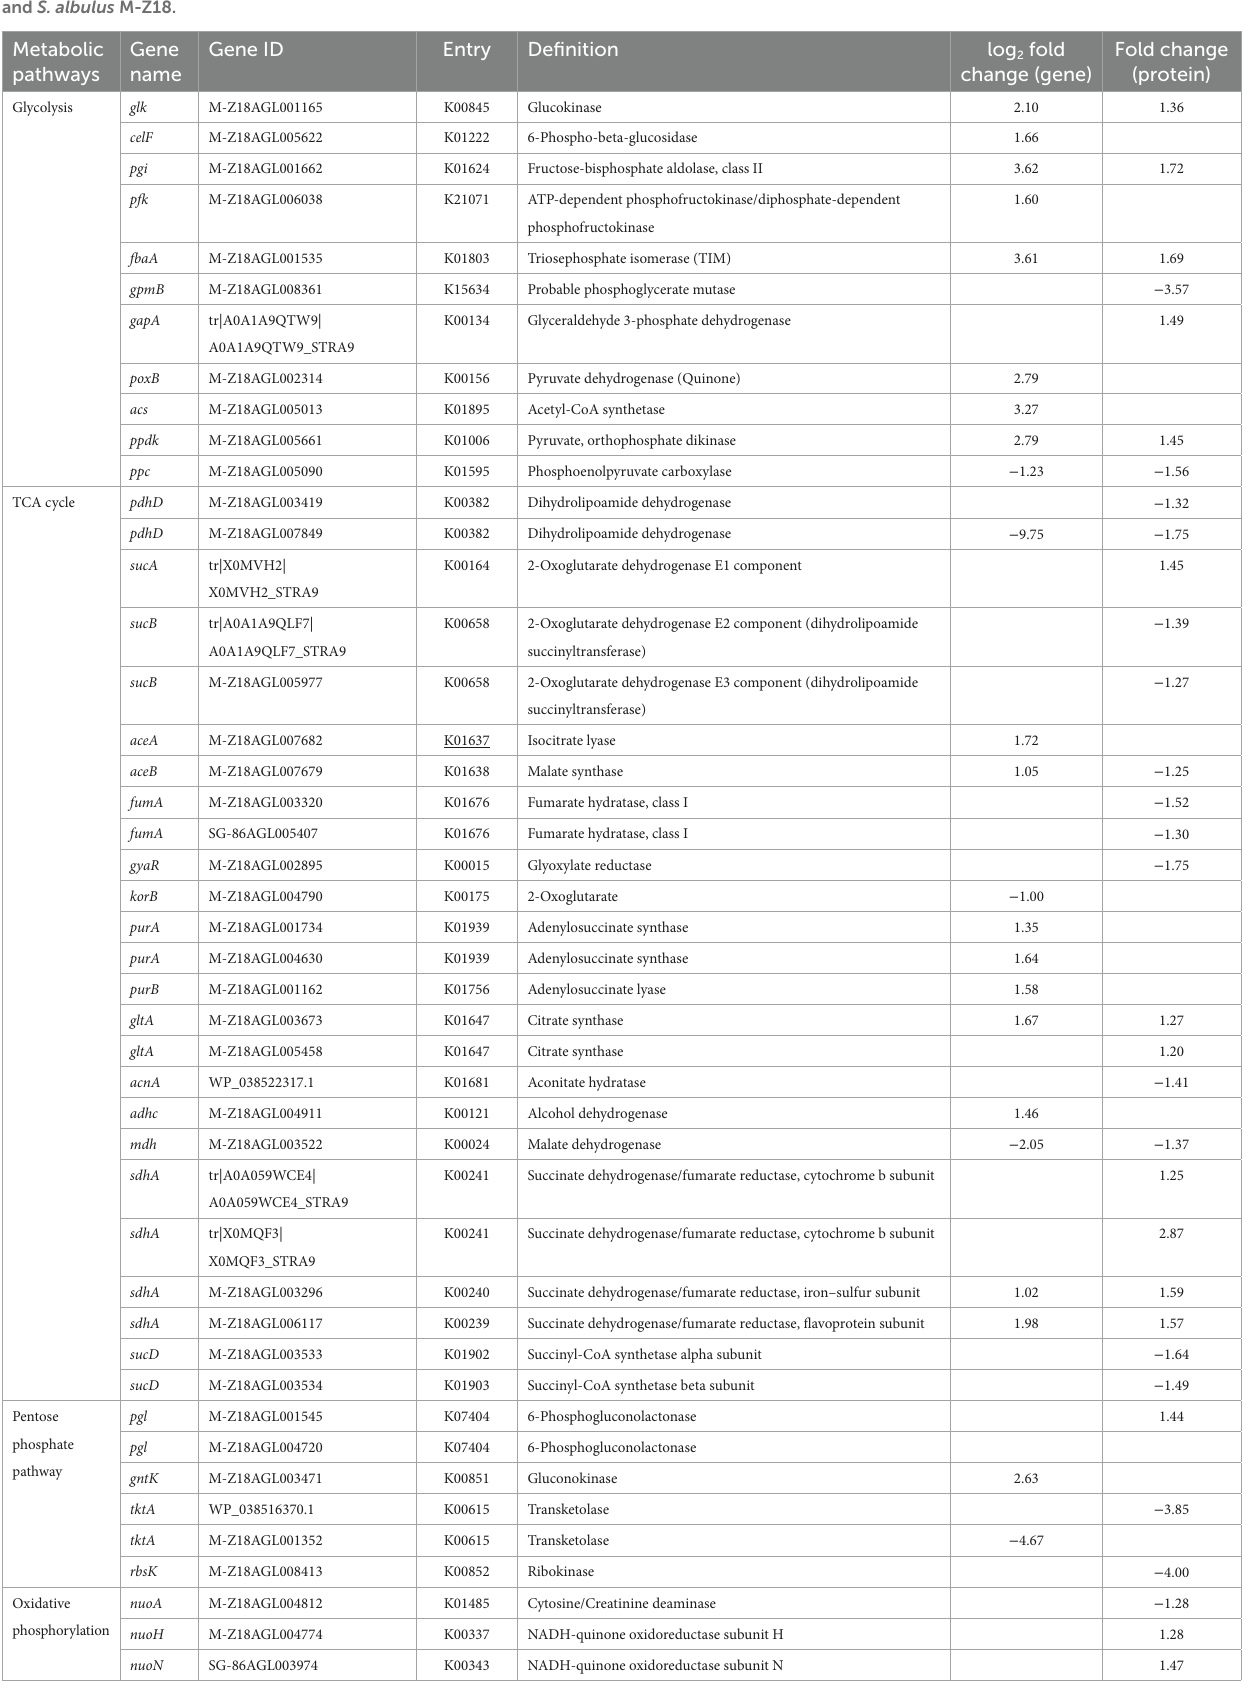
TABLE 2 Differential expression genes and proteins associated with carbohydrate metabolism and L-lysine biosynthesis between S. albulus WG-608 and S. albulus